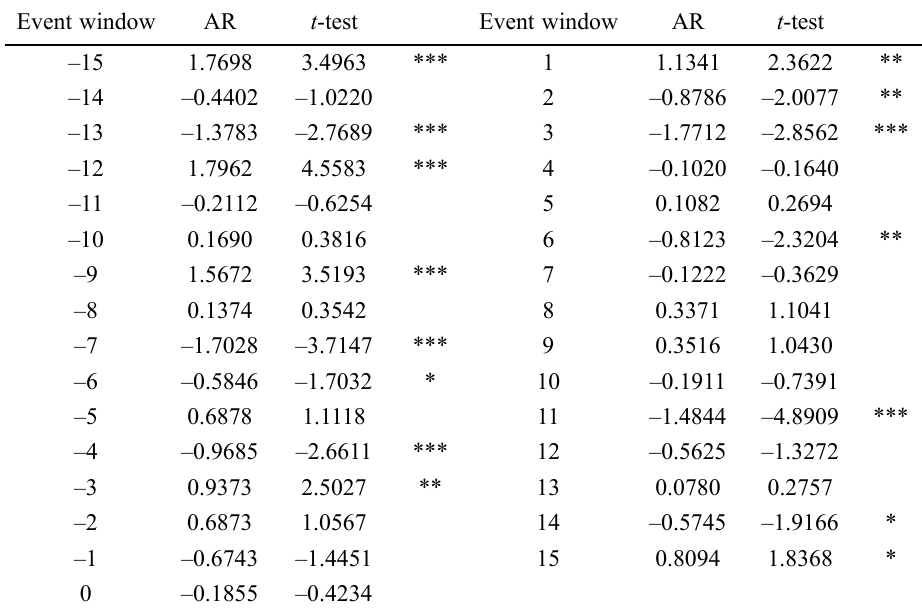
Table 3. Average AR of pharmaceutical during the period of infectious diseases Event